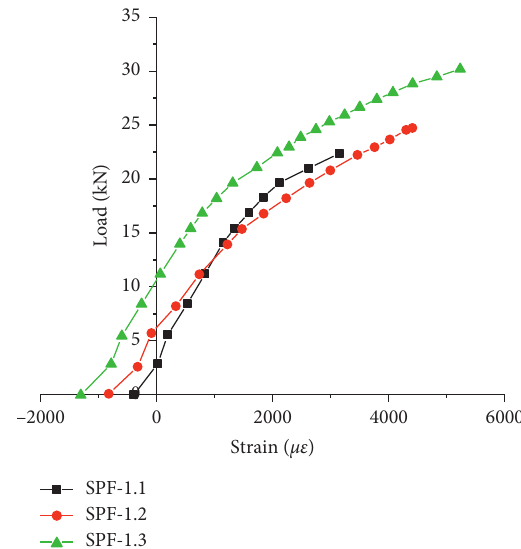
Figure 10: Load-strain curve of the fifth-layer laminate of the test beam in group